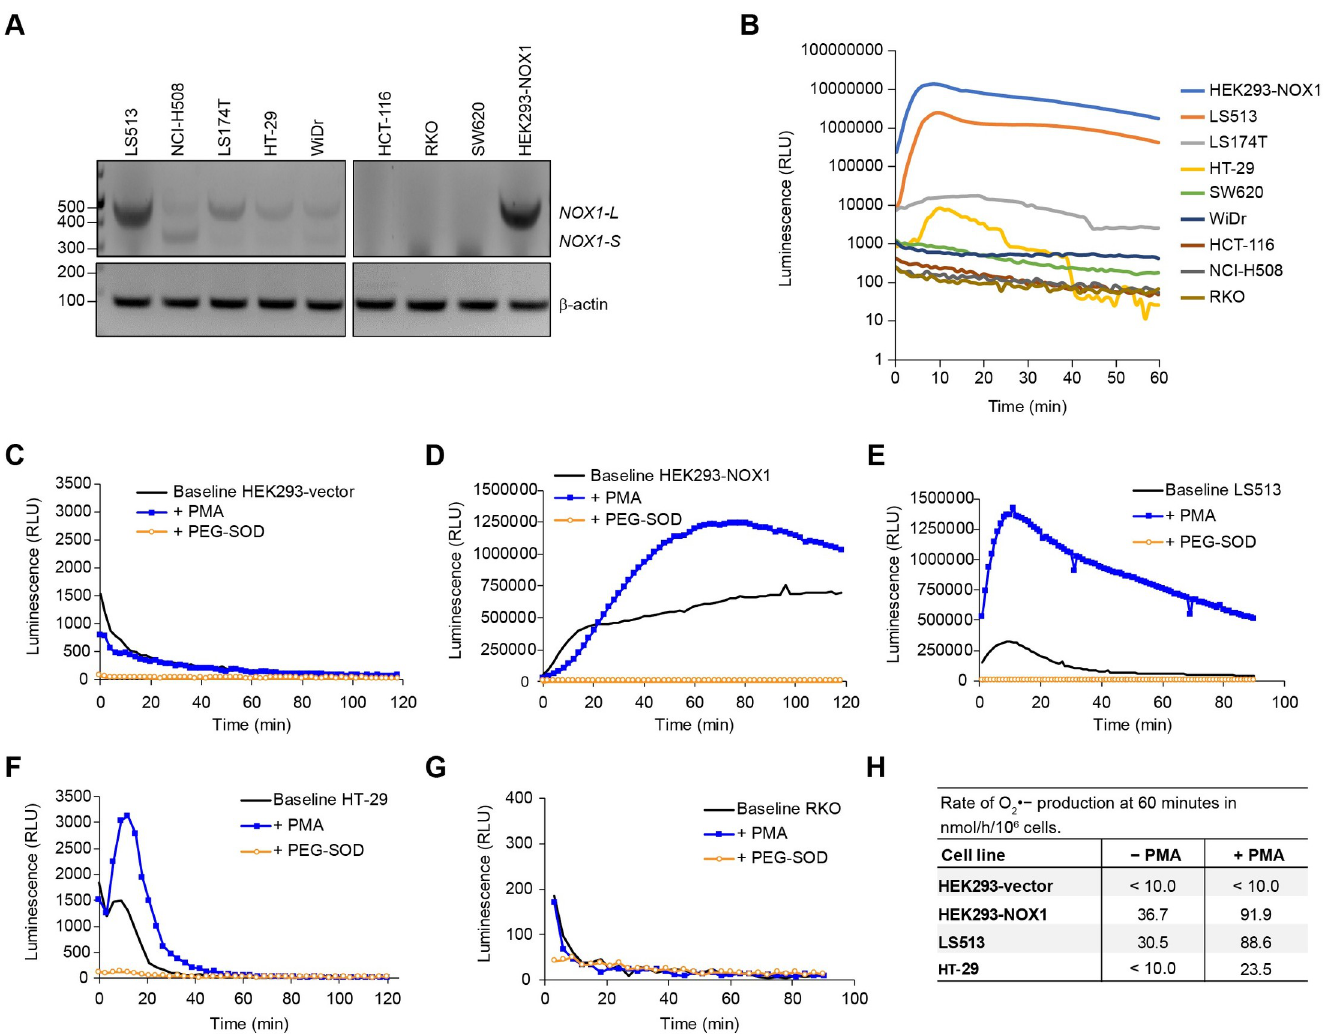
Fig 3. Functional expression of NOX1 isoforms in human colon cancer cell lines. (A) RT-PCR and subsequent DNA gel analyses were performed to detect NOX1-L and NOX1-S / NOX1-Lv in a subset of 8 colon cancer cell lines plus HEK293-NOX1. (B) The subset of cell lines was evaluated for PMA-stimulated superoxide production by luminescence assay. (C-G) Basal and PMA-stimulated superoxide production were also measured in (C) HEK293-vector control, (D) HEK293-NOX1, (E) LS513, (F) HT-29, and (G) RKO cells using the luminol assay. Superoxide dismutase-polyethylene glycol (PEG-SOD, 200 U/ml) was used to confirm superoxide production, with measurements taken every 2 min for up to 120 min. (H) Mean rate of superoxide production at 60 min in nmol/h/10 6 cells. 2X10 6 cells per well were suspended in 200 μ l of HBSS-HEPES containing 100 μ M acetylated cytochrome c with or without 200 nM PMA and/or 200 U/ml PEG-SOD. The change in optical density at 550 nm was quantified using the kinetics of cytochrome c reduction. To eliminate superoxide-independent cytochrome c reduction, the absorbance value with PEG-SOD was subtracted from the absorbance value with cytochrome c alone for each cell line system.